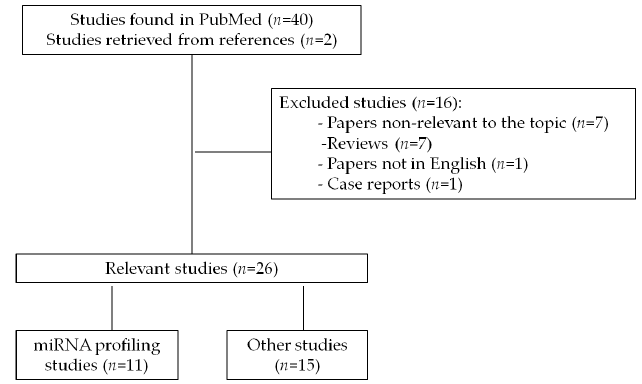
Figure 1. Flow diagram of the original research papers search strategy and identification of studies relevant for review.